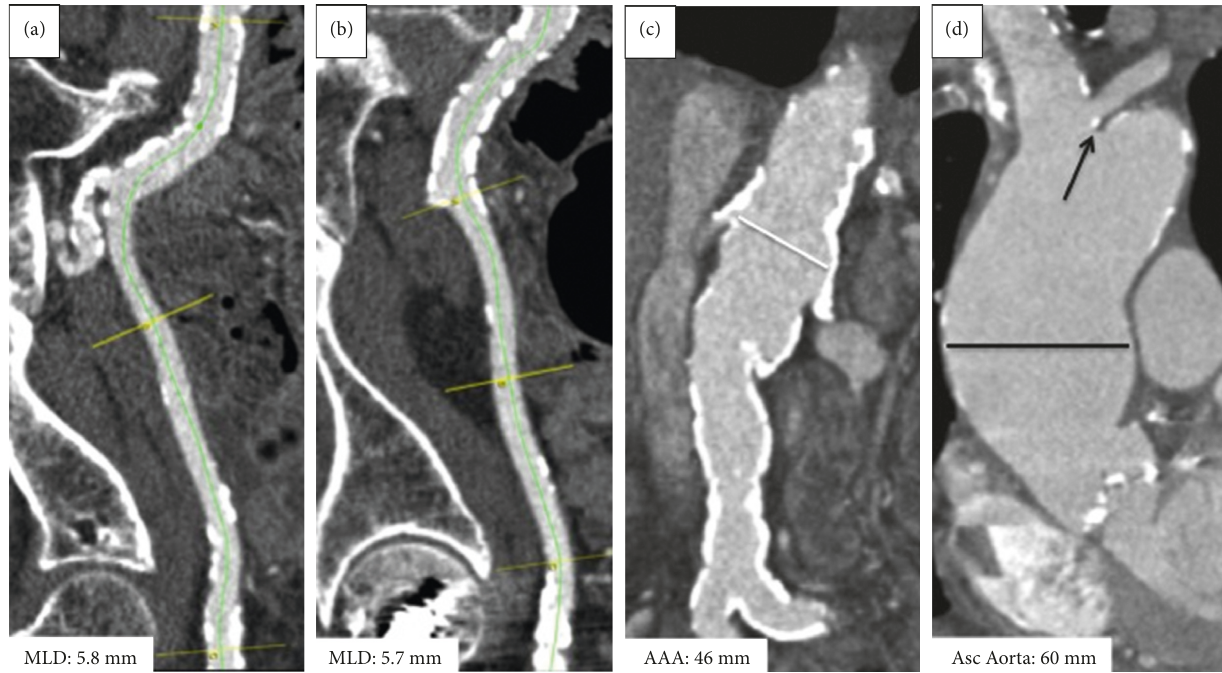
Figure 1: (a) MSCTof the right illiofemoral artery demonstrating an MLD of 5.8mm. (b) MSCTof the left illiofemoral artery demonstrating heavy calcification just at the level of the femoral head and an MLD of 5.7mm. (c) MSCTof the descending aorta. The white line denotes the maximum diameter of 46mm. (d) MSCT of the ascending aorta. The black line denotes the maximum diameter of the ascending aorta aneurysm measuring 60mm. The black arrow shows the left subclavian entering the right brachiocephalic trunk (the bovine arch).